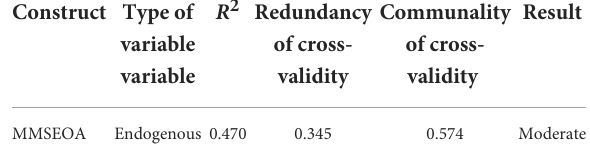
TABLE 7 Hypotheses overview. TABLE 8 Predictive quality of framework.